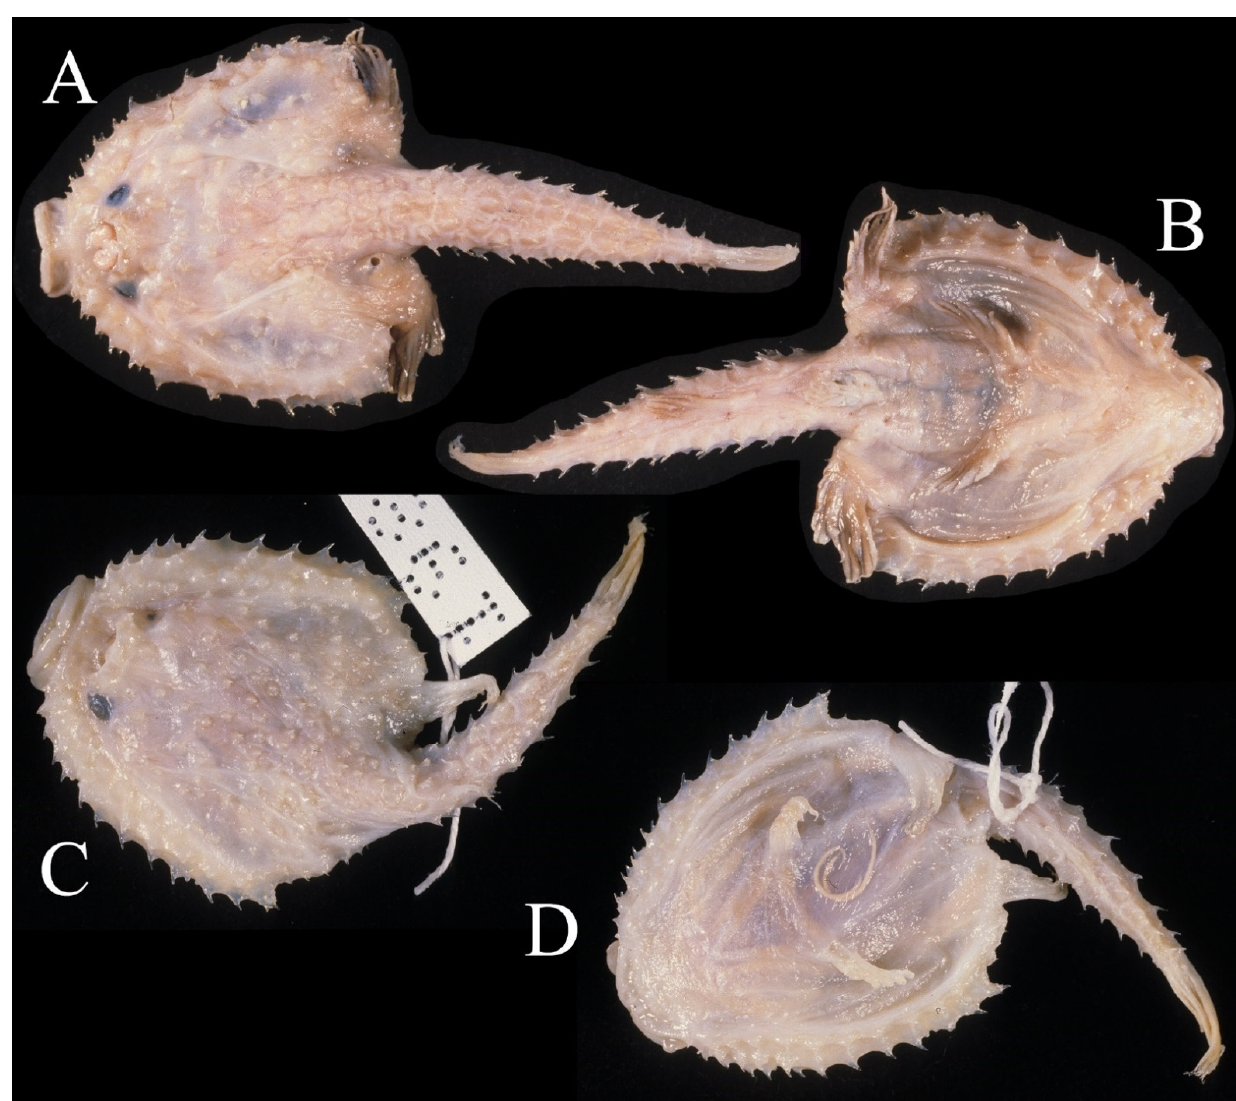
Figure 11. Halieutopsis ingerorum Bradbury, 1988. ( A , B ). ZMMU P20363, 78.8 mm SL, South Africa. ( C , D ). MNHN 1986-0027, 70.1 mm SL, Madagascar. ( A , C ). Dorsal view. ( B , D ). Ventral view. Photos by M. G. Bradbury.